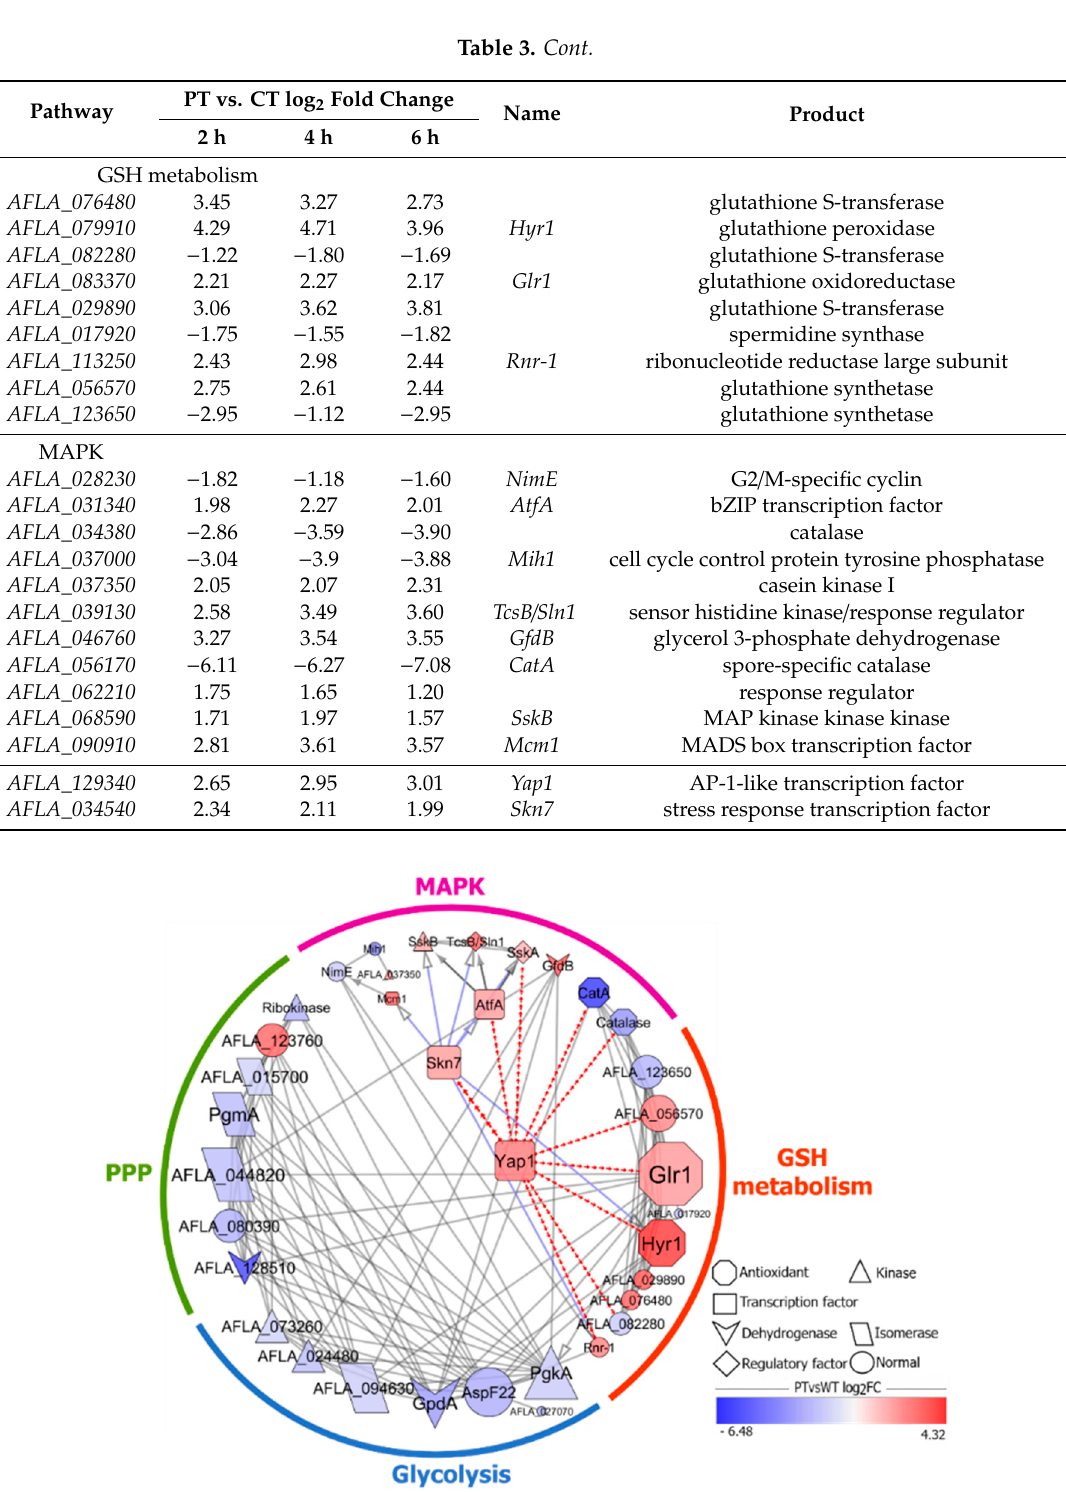
Figure 7. Protein-protein interaction network of di ff erentially expressed genes. The icon size is proportional to the number of protein-protein interactions. Red fill color stands for positive regulation of proteins encoded by corresponding genes, and blue fill color for negative regulation of